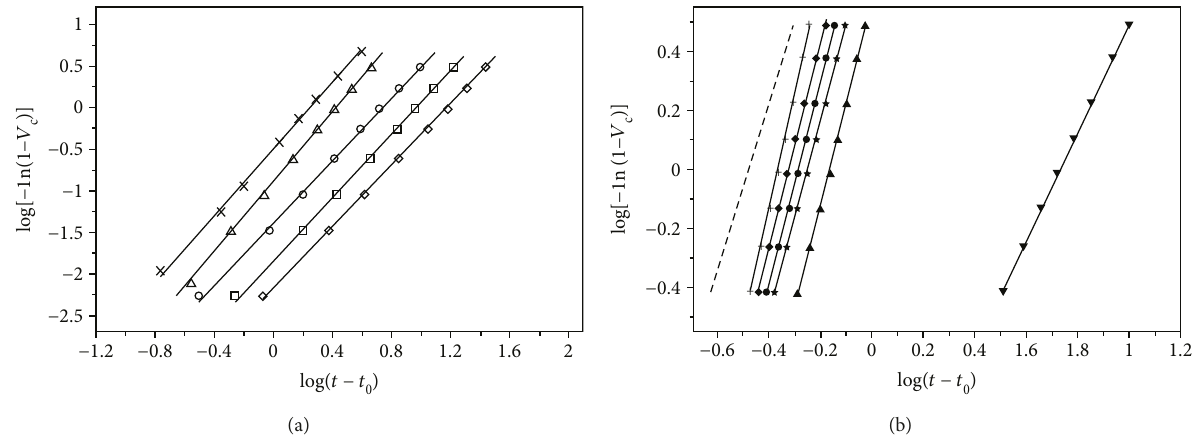
Figure 8: Experimental data obtained from the isothermal crystallization of (a) HEMACL3 at di ff erent crystallization temperature ( T = 16 ° C , ( Δ ) T = 18 ° C , ( ○ ) T = 20 ° C , ( □ ) T = 22 ° C , and ( ◊ ) T = 24 ° C and (b) linear poly( ε -caprolactone) homopolymer symbols: ( × ) T c c c c c = 20 ° C , symbols: ( − ) linear PCL, ( + ) SCL4, ( ♦ ) SCL3, ( ● ) SCL2, ( ★ ) SCL1, PCL and SCL# and HEMACL# copolymers crystallized at T c ( ▲ ) HEMACL1, and ( ▼ )